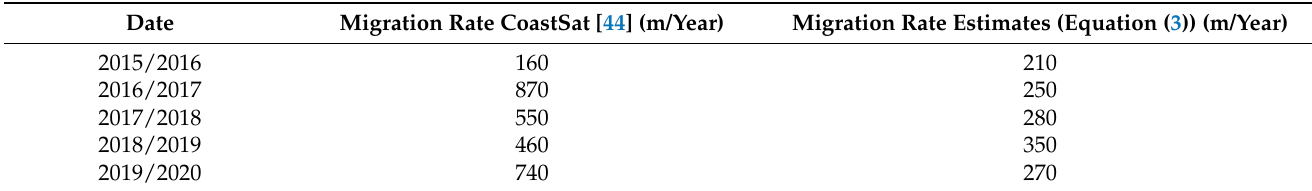
Table 3. Migration rates over the years derived from satellite measurements and Equation (3).